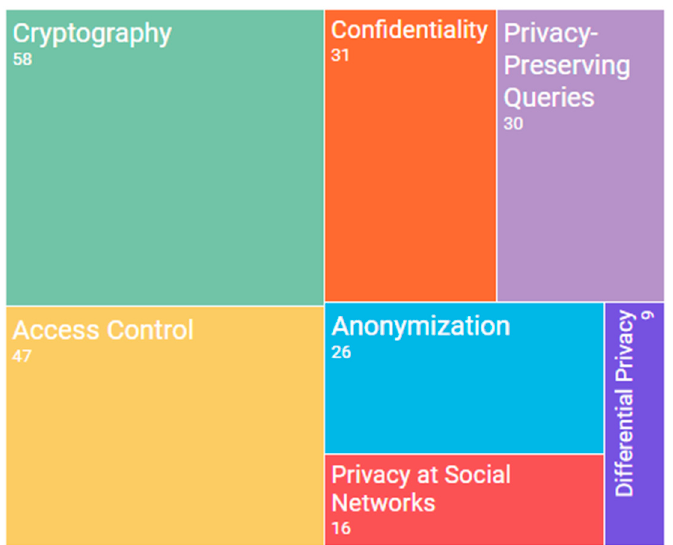
Figure 4. Main topics on data privacy.